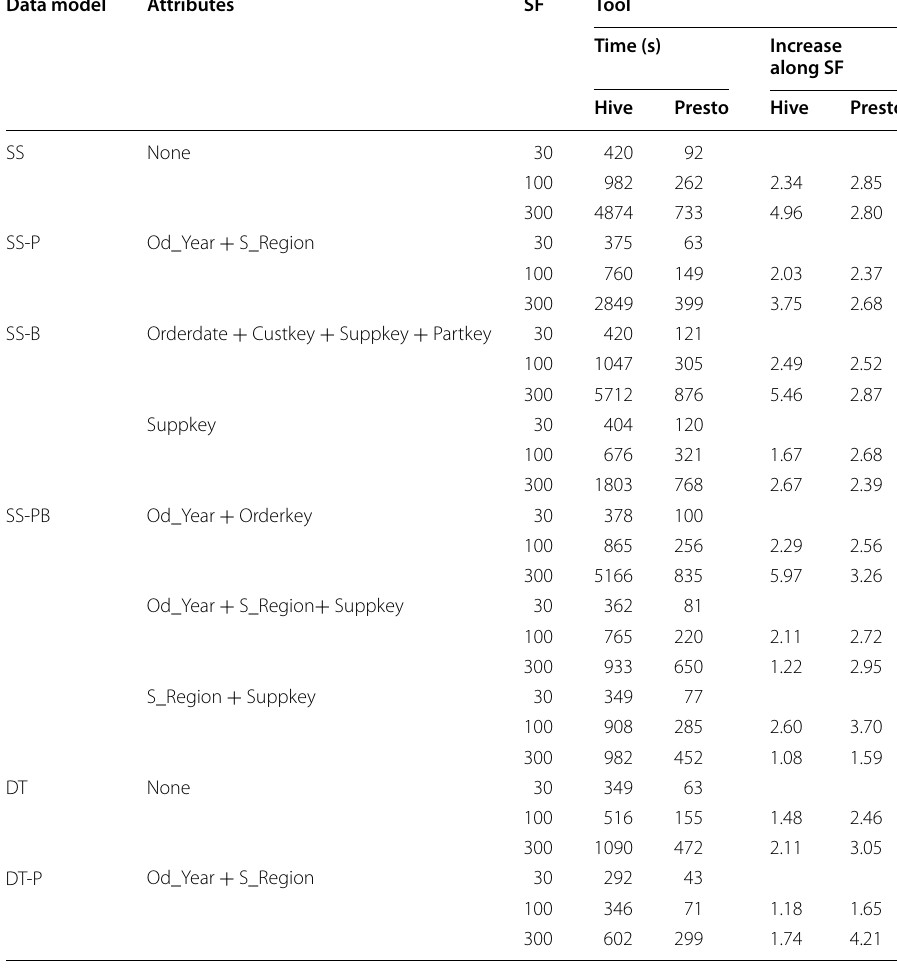
Table 19 Total query execution time for 30 GB, 100 GB and 300 GB Data